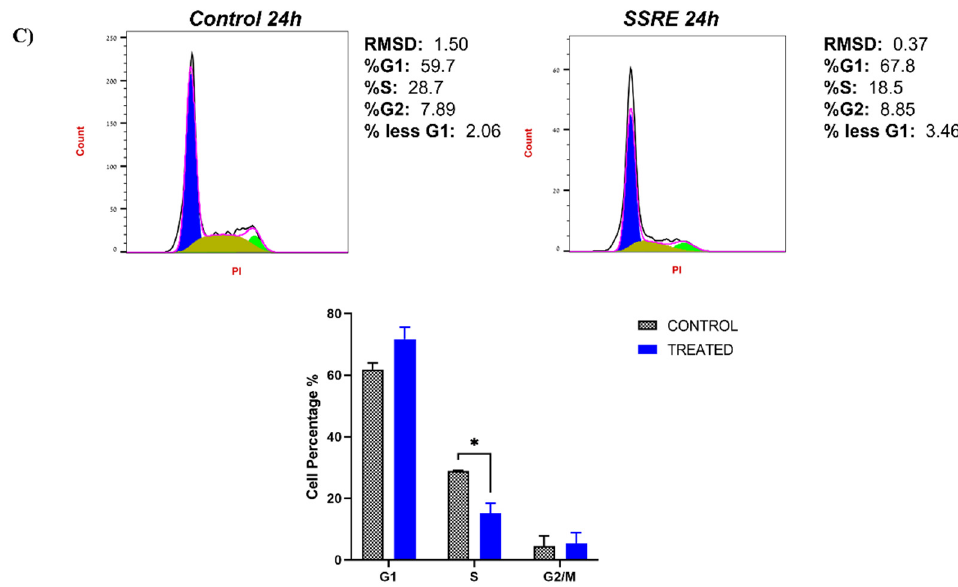
Figure 3. Anti-cancer effects of the SSE extract. ( A ) Effects of extract on WNT/Beta-catenin and TGF-beta signaling pathways. A549 cells were incubated with the extract for 6 h and levels of β -catenin and TGF-beta were assessed by immunoblotting with the corresponding antibodies. ( A ) Levels of β -catenin and level of SMAD2. ( B ) Real-Time PCR measurement of cancer-related pathways’ genes. On the left, Spliceosome genes (SRSF11 and PNN), and on the right genes belong to the Cell cycle pathway described (CCP110 and CEP152). Results are representative of three biological replicates ( n = 3). *, p < 0.05; **, p < 0.01; ***, p < 0.005; ****, p < 0.001 (treated vs. control). ( C ) Cell cycle analysis. Flow Cytometry analysis of non-treated (on the left) and extract-treated (for 24 h) (on the right) A549 lung cancer cells. The Bar graph below shows the quantitative analysis of the flow cytometry experiments described above ( n = 3). Data are presented as mean ± S.D. *, p < 0.05.